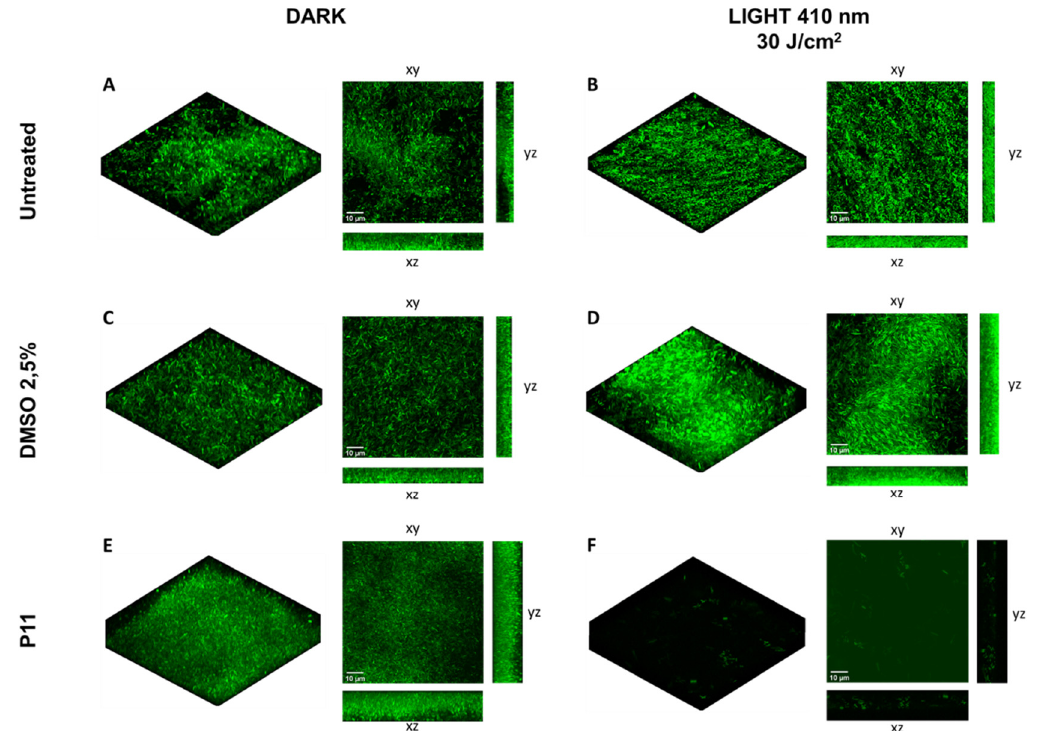
Figure 6. Inhibition of biofilm formation by P. aeruginosa PAO1-GFP by dicationic diaryl-porphyrin P11. GFP-tagged PAO1 cells were inoculated on coverslip glass and treated with P11 30 µ M for 1 h in the dark. Cells were irradiated with light at 410 nm (30 J/cm 2 ) and incubated at 37 ◦ C in static to let form biofilm. After overnight incubation, GFP expression was induced and biofilm formed on glasses was analyzed by confocal microscopy. Untreated and DMSO-treated biofilms are included as controls. Confocal images of dark controls are shown in panels ( A , C , E ), while irradiated samples are shown in panels ( B , D , F ). Images of biofilms are shown in volume view, and in xy, xz and yz projections (scale bar = 10 µ